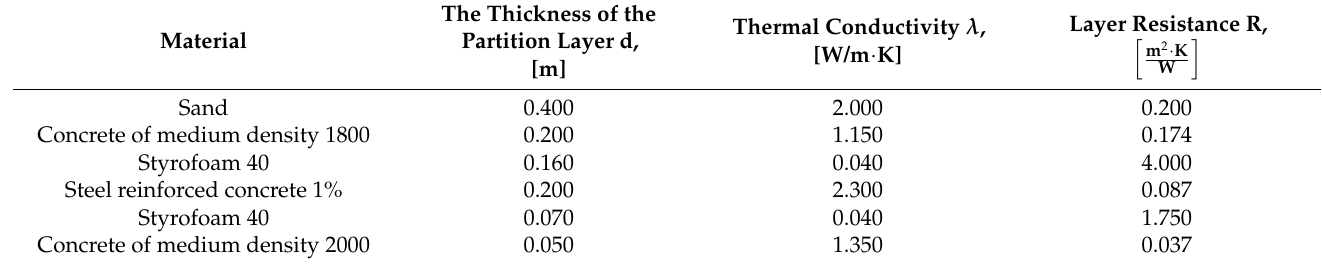
Table 6. Characteristics of the partition-floor on the ground.